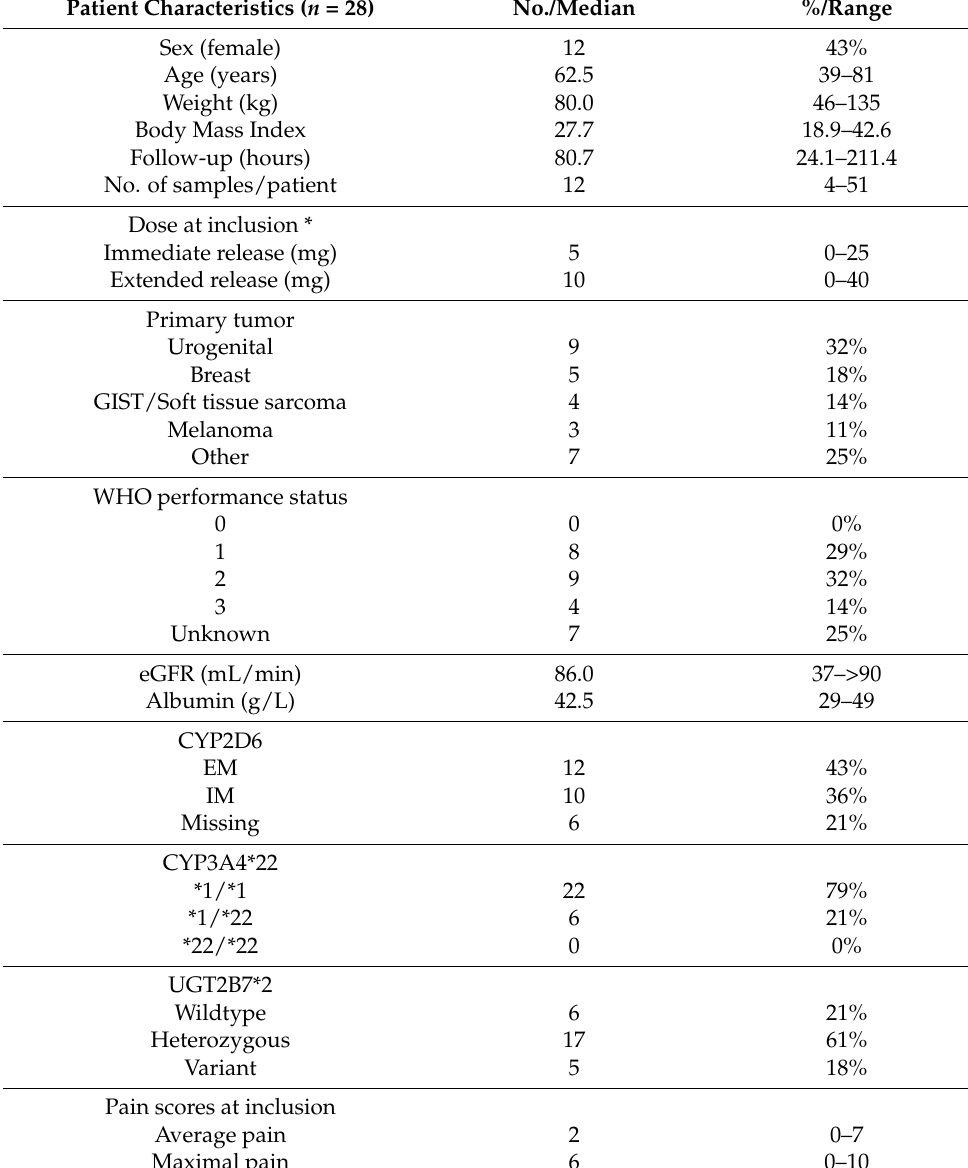
Table 1. Patient